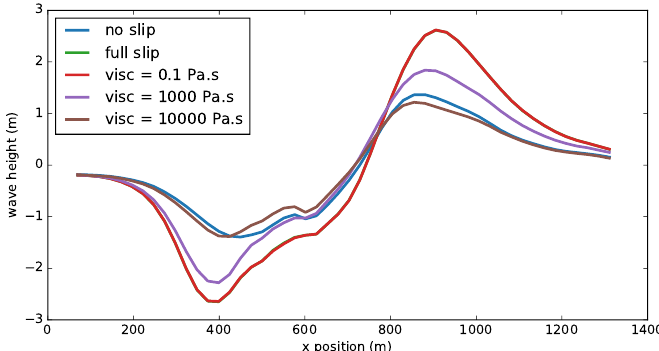
Figure 2. Test case for the range of boundary layer viscosities. The two extreme values coincide well with the no- and full-slip